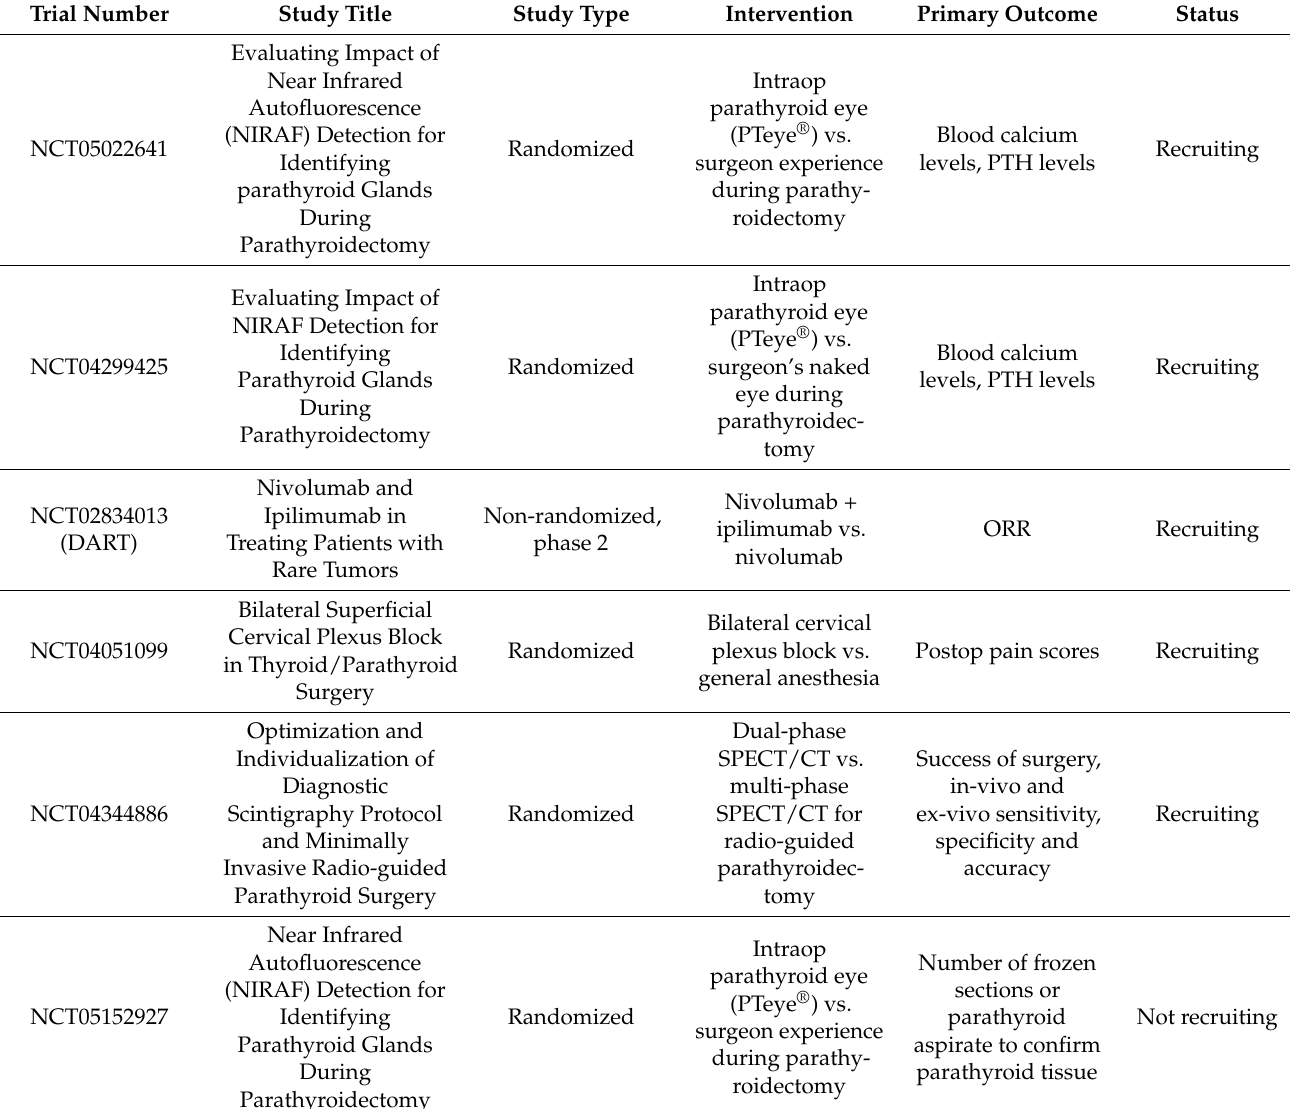
Table 9. Selected ongoing trials in parathyroid carcinoma (source: Clinicaltrials.gov, accessed on 24 January